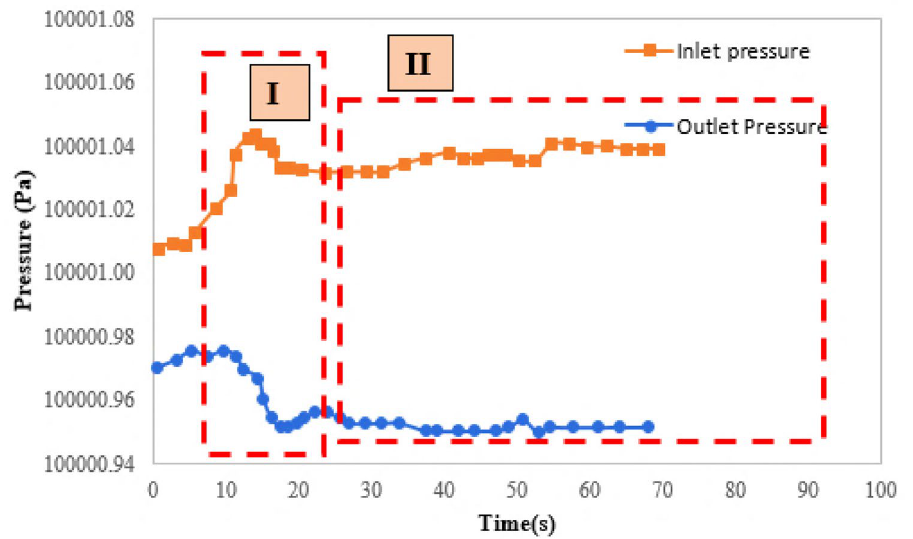
Figure 11. Pressure variations at inlet and outlet of the micromodel for blockage mechanism.